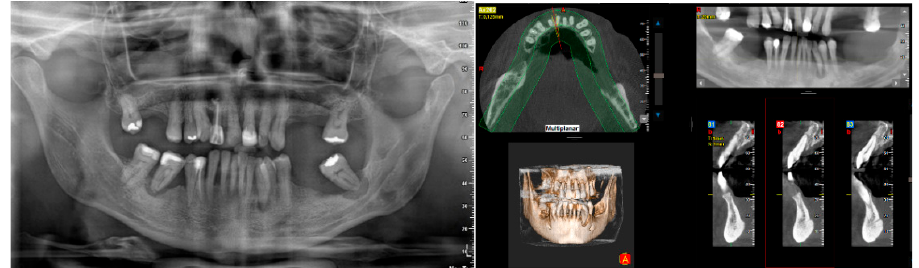
Figure 1. Panoramic radiograph and computerized tomography as part of the diagnosis and treatment plan.